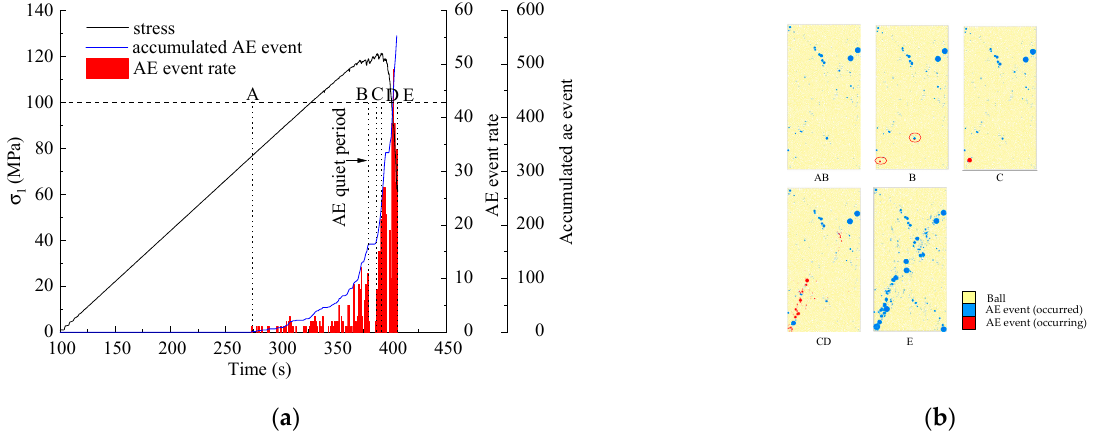
Figure 4. Numerical simulation results. ( a ) Stress and AE events of specimens with homogeneous rock specimens; ( b ) AE events distribution at different stages of the specimen.